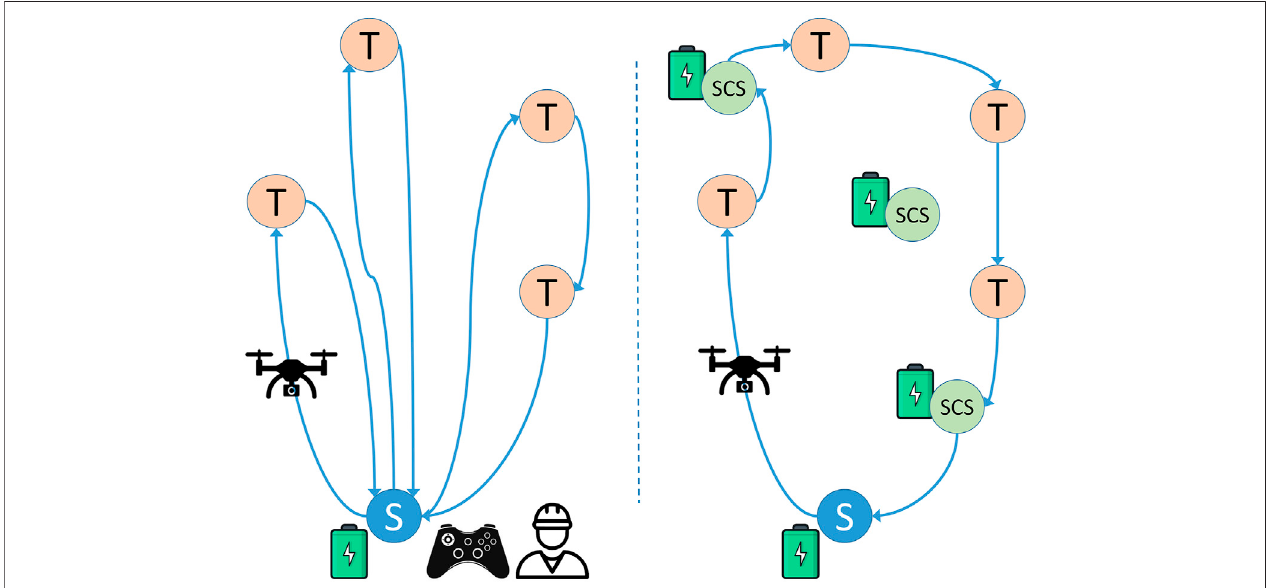
FIGURE 1 | Left: A classical inspection methodology. Drones start from S and are remotely controlled to visit all targets (T), coming back to the starting point (S) when their batteries need recharging or replacing. Right: Social Drone Sharing (SDS) approach. Drones autonomously visit all targets, by landing at a Social Charging Station (SCS) whenever their batteries need recharging or